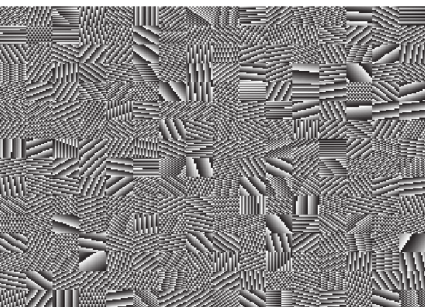
Figure 1: Generation of deterministic phase mask (DPM) for m �